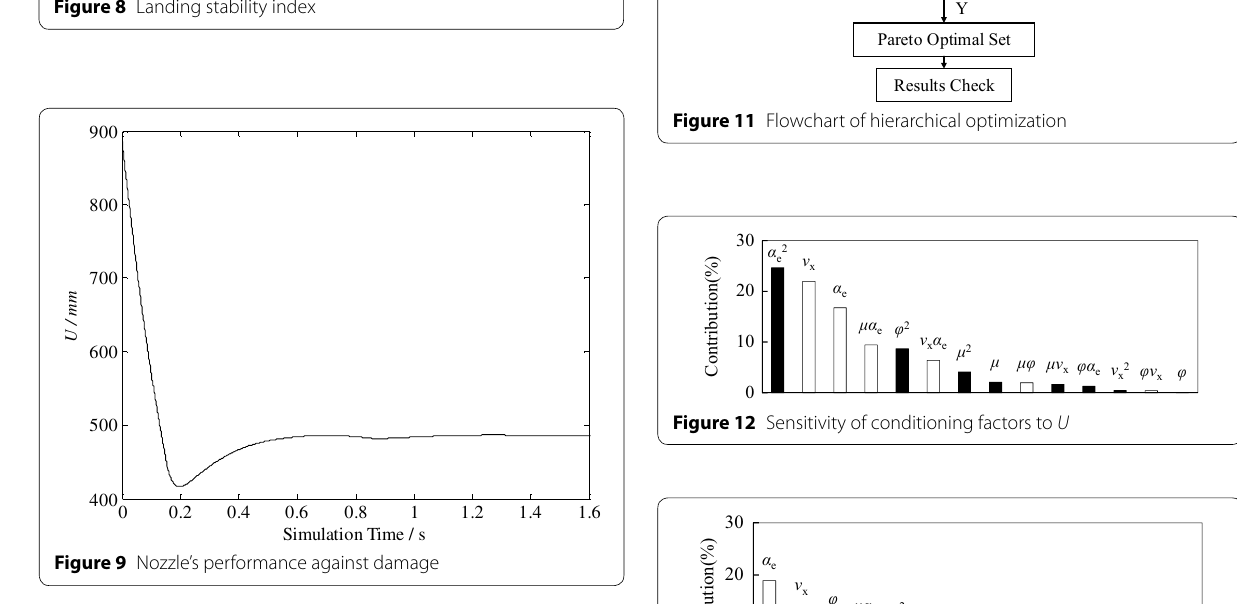
Figure 13 Sensitivity of conditioning factors to L